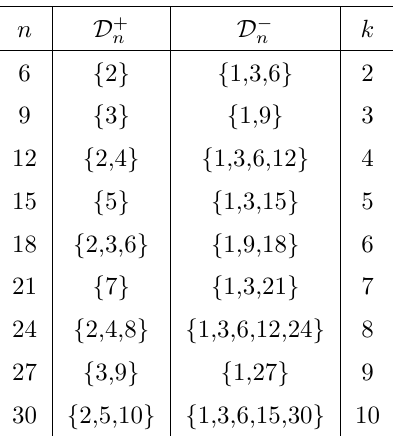
( y ) from (3.16). The third column n